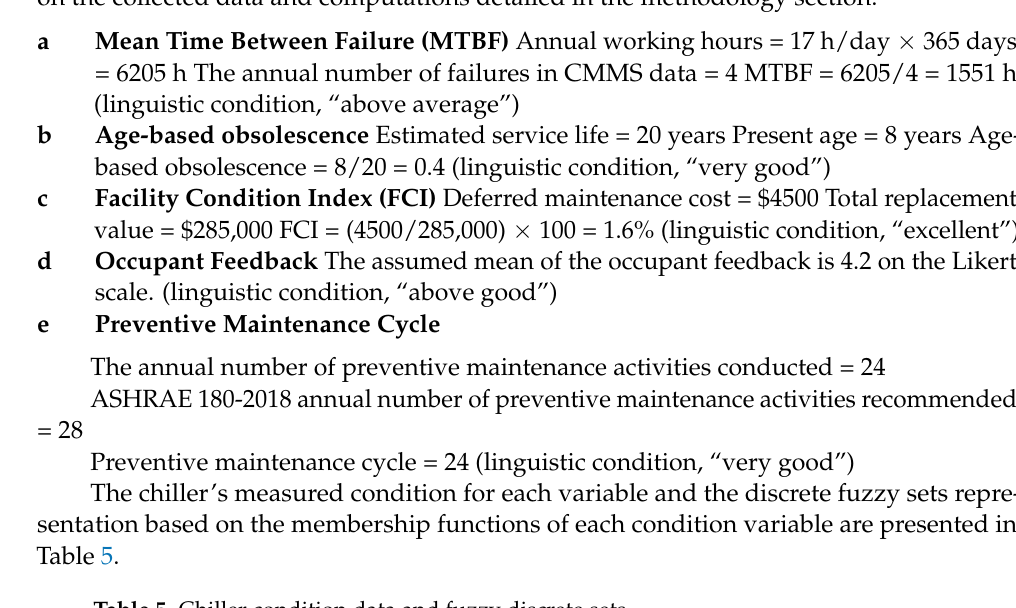
Table 5. Chiller condition data and fuzzy discrete